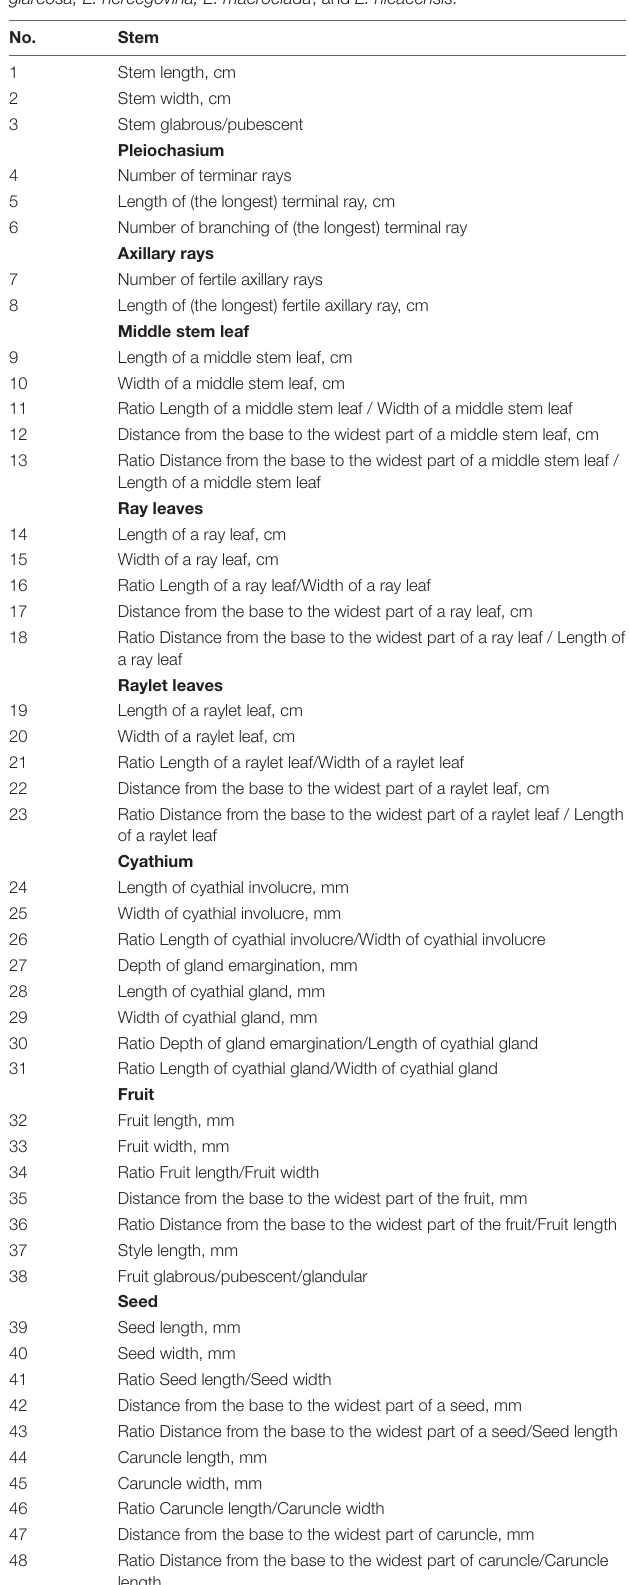
TABLE 1 | Characters studied in the morphometric analyses of Euphorbia glareosa, E. hercegovina, E. macroclada , and E. nicaeensis.